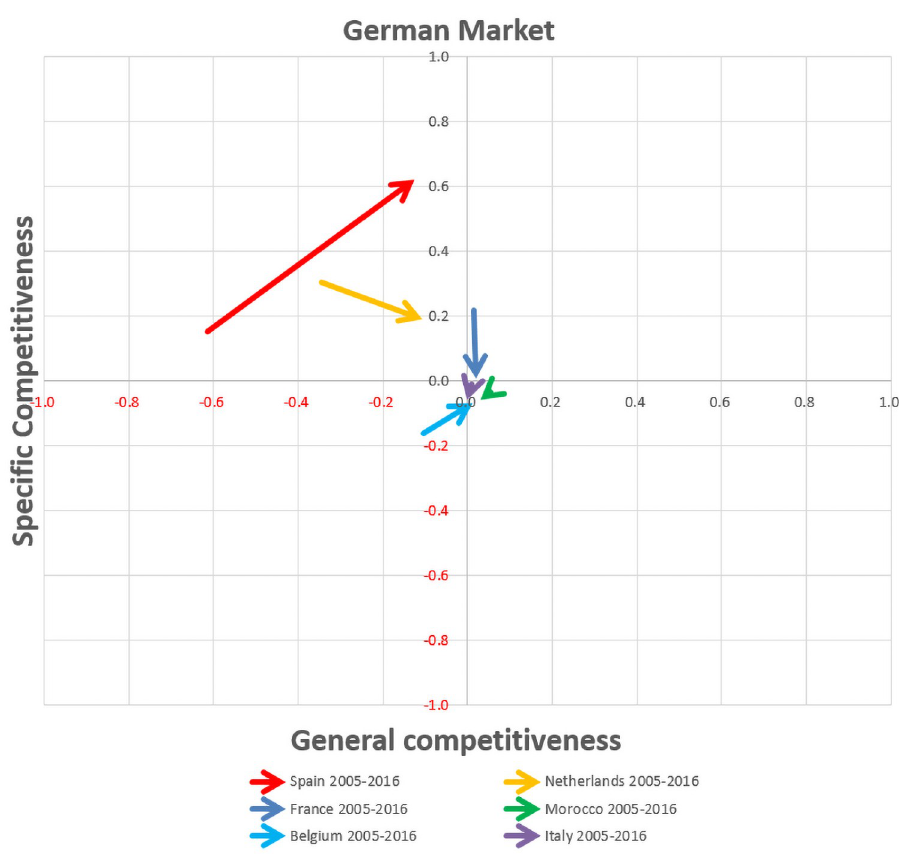
Fig 16. Competitiveness map for competing countries group in the German